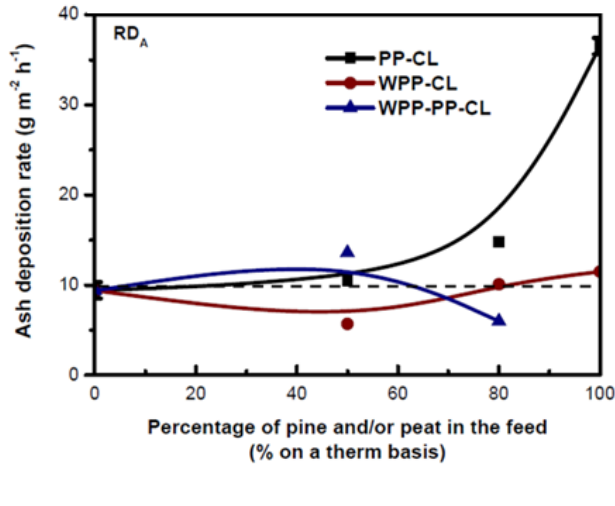
obtained from the combustions Figure 5. Comparison of relative ash deposition rates RD A of 100% lignite and three-fuel blends FB1 (25% WPP + 25% PP + 50% CL) and FB2 (40% WPP + 40% PP + 20% CL), in comparison with those from combustion of 50% WPP + 50% CL, 50% PP + 50% CL, 80% WPP + 20% CL, 80% PP + 20% CL as well as 100% WPP, and 100% PP (modified from